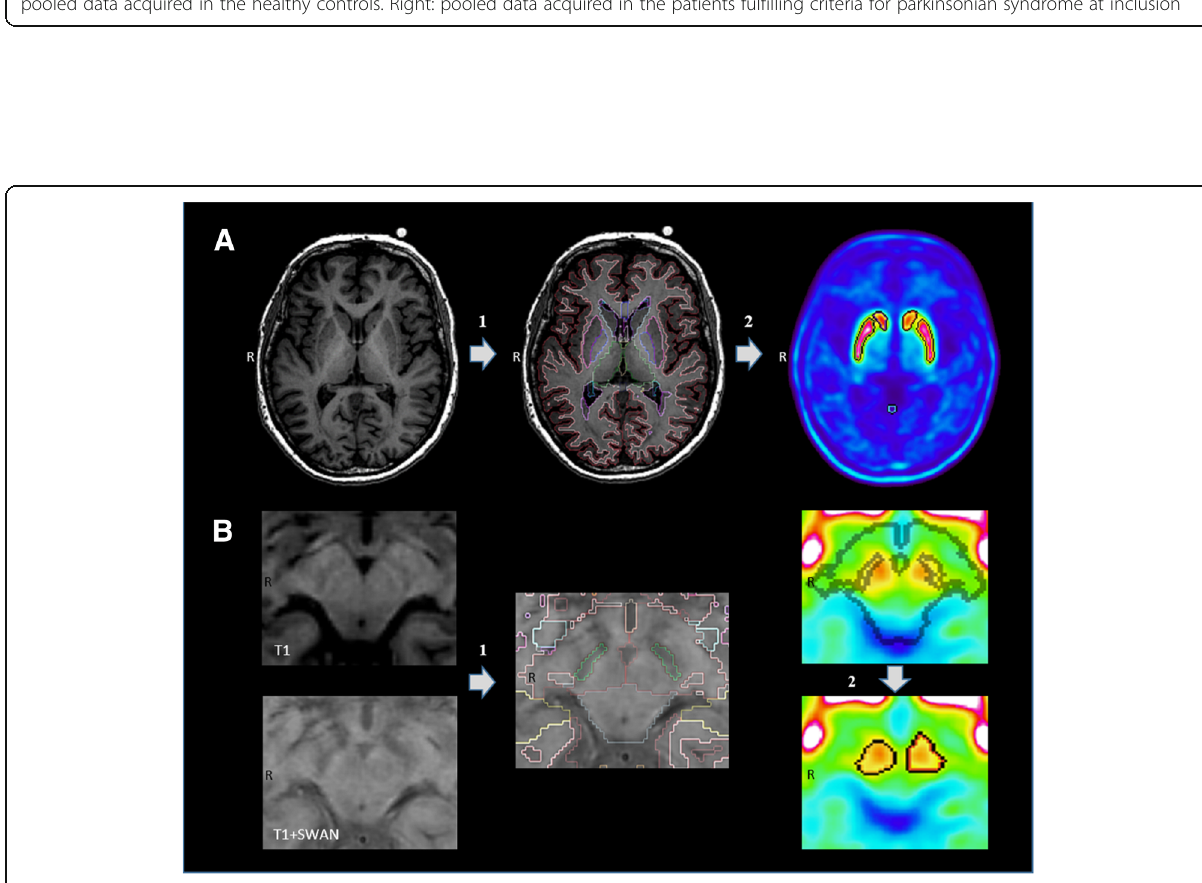
Fig. 3 Illustration of the procedure for PET image analysis. a Measurement of the FE-PE2I activity in the caudate and the putamen: In the first step (1), T1-weighed MRI data was automatically segmented using Freesurfer, delineating the structural borders of the caudate and putamen in each hemisphere. In the second step (2), delineation of the PET-data was done, restricted by the limits of the segmented VOIs created in the first step. New PET-based VOIs were delineated for the caudate and putamen, defined as the voxels with the highest activity within a volume of 2.0 and 2.5 mL respectively. This was done to adjust for imprecise Freesurfer MRI segmentation, due to periventricular white matter irregularities, and to minimize partial volume effects in the PET image data. b Measurement of the FE-PE2I activity in the SN. In the first step (1), manual segmentation was anatomically guided by the hypo-intense area in the midbrain corresponding to SN on merged SWAN and T1-weighted MRI transversal slices. Since the MRI-guided VOIs did not entirely overlap the area of the observed FE-PE2I binding in the midbrain, in the second step (2), these segmented VOIs were used to guide an automatic thresholding algorithm to determine PET-based midbrain VOIs. FE-PE2I, [ 18 F]FE-PE2I PET; MRI, magnetic resonance imaging; VOI, volume of interest; SN, substantia nigra; SWAN, susceptibility-weighted